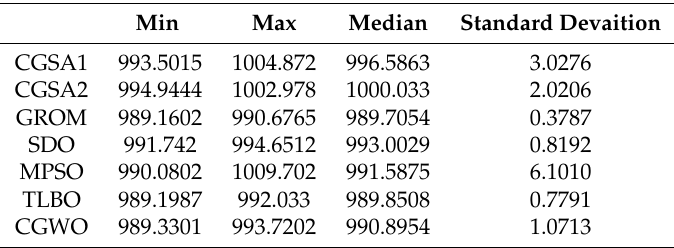
Table 11. Statistical analysis for case